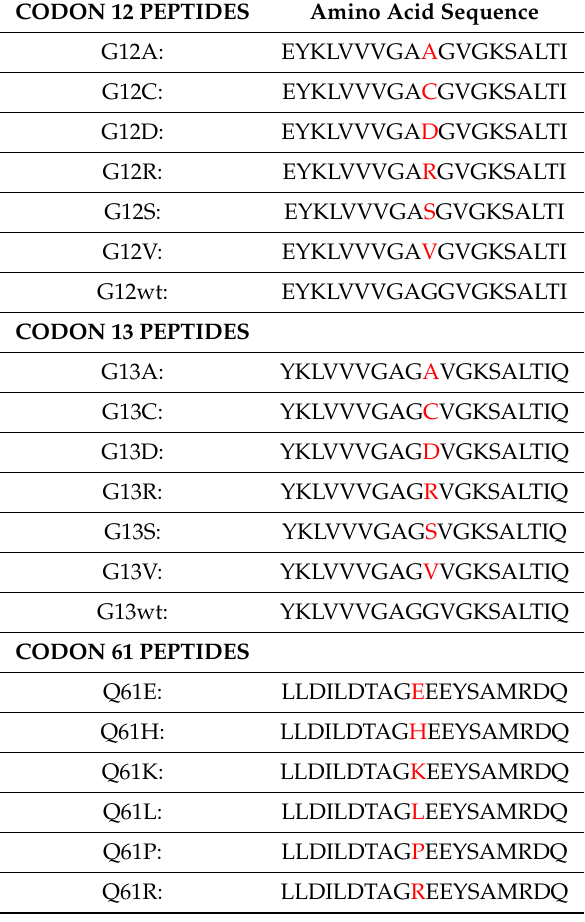
Table 1. Amino acid sequences of the peptides derived from mutant RAS used in this study. For the mutant epitopes, the substituted amino acid has been marked with a red